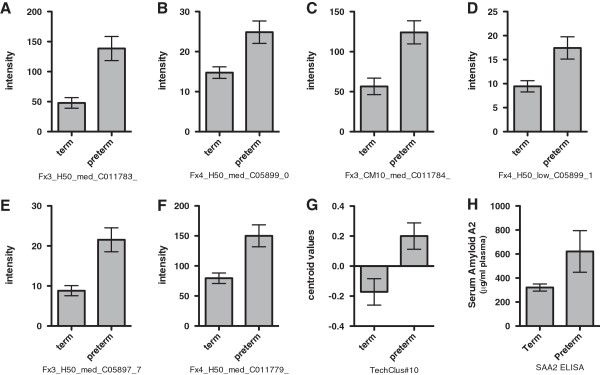
Test results from one technical cluster from a biomarker discovery dataset of a mouse preterm labor model. The intensities of six SELDI-TOF MS peaks for term labor and preterm labor are shown in A – F. These peaks formed a technical cluster at a variance threshold of 0.3. The cluster centroids for term and preterm labor for this cluster is shown in G. The subsequent ELISA assay results for serum amyloid A2 are shown in H, after identification of candidate biomarker by chromatographic purification, gel purification, and sequencing of tryptic fragments as previously described in the text. Panels A - G are mean ± sem with n = 7 for Term and n = 6 for Preterm. Panel H is mean ± sem with n = 5 for both Term and Preterm.